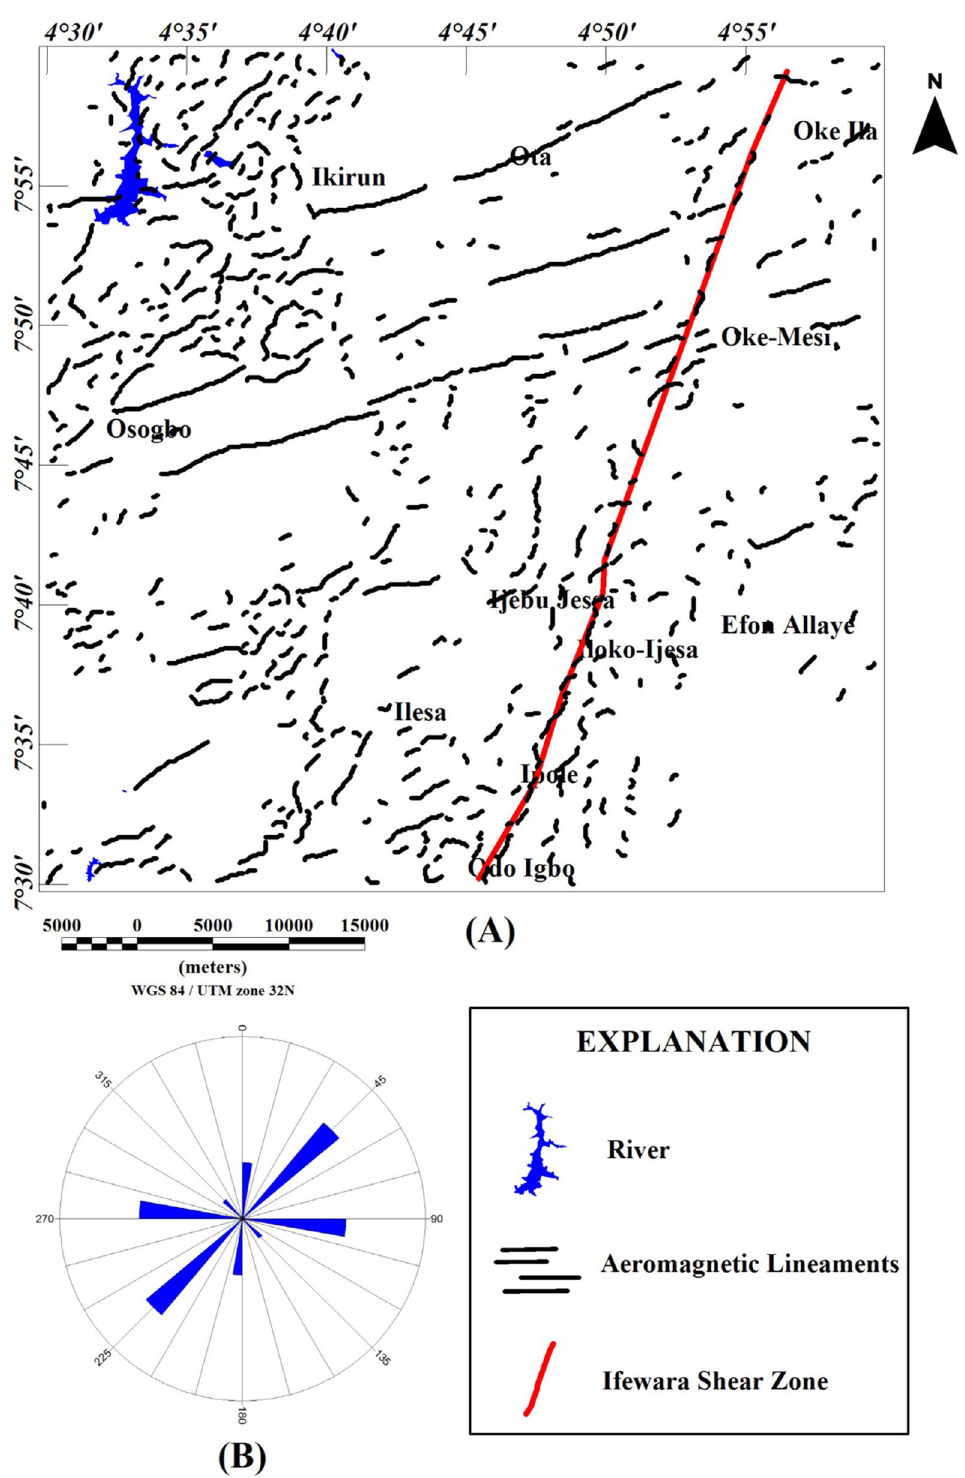
Figure 9. ( A ) Magnetic structural map showing extracted maxima of the total gradient amplitude (TGA), which was used for locations and lateral extent of structural features. ( B ) Rose diagram produced from the maxima of TGA, showing major NE-SW and E-W structural trends. ( A ) was produced using Oasis Montaj Software version 8.3.3 (Website: https:// www. seequ ent.